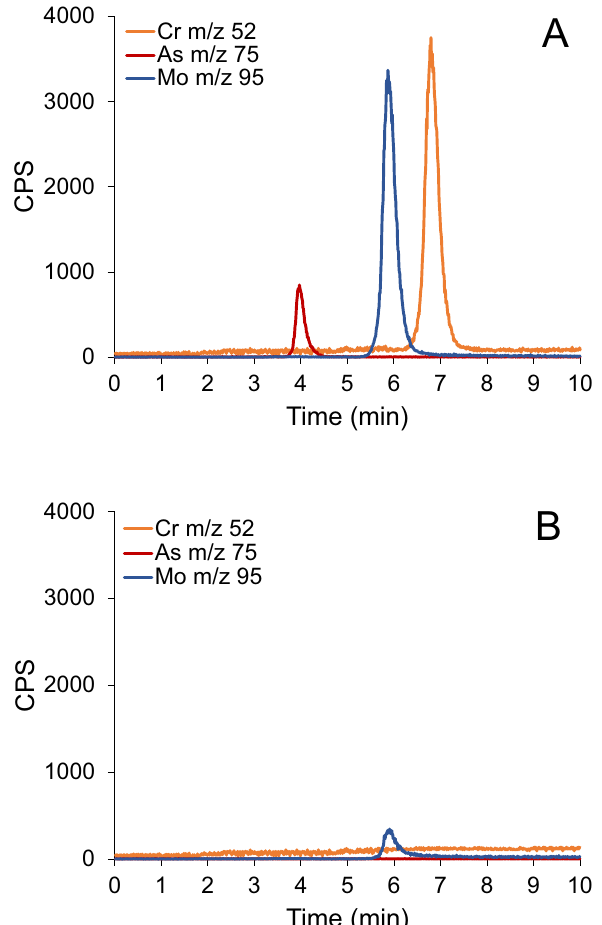
Figure 1. Simultaneous separation of chromate, molybdate and arsenate in 0.2% NaOH + 0.3% Na 2 CO 3 buffer (pH 12) on the HPLC Mono Q column followed by ICP-MS detection at m/z 52, 95 and 75, respectively. ( A ) chromate, molybdate and arsenate (50 ng mL −1 of element), ( B ) blank.